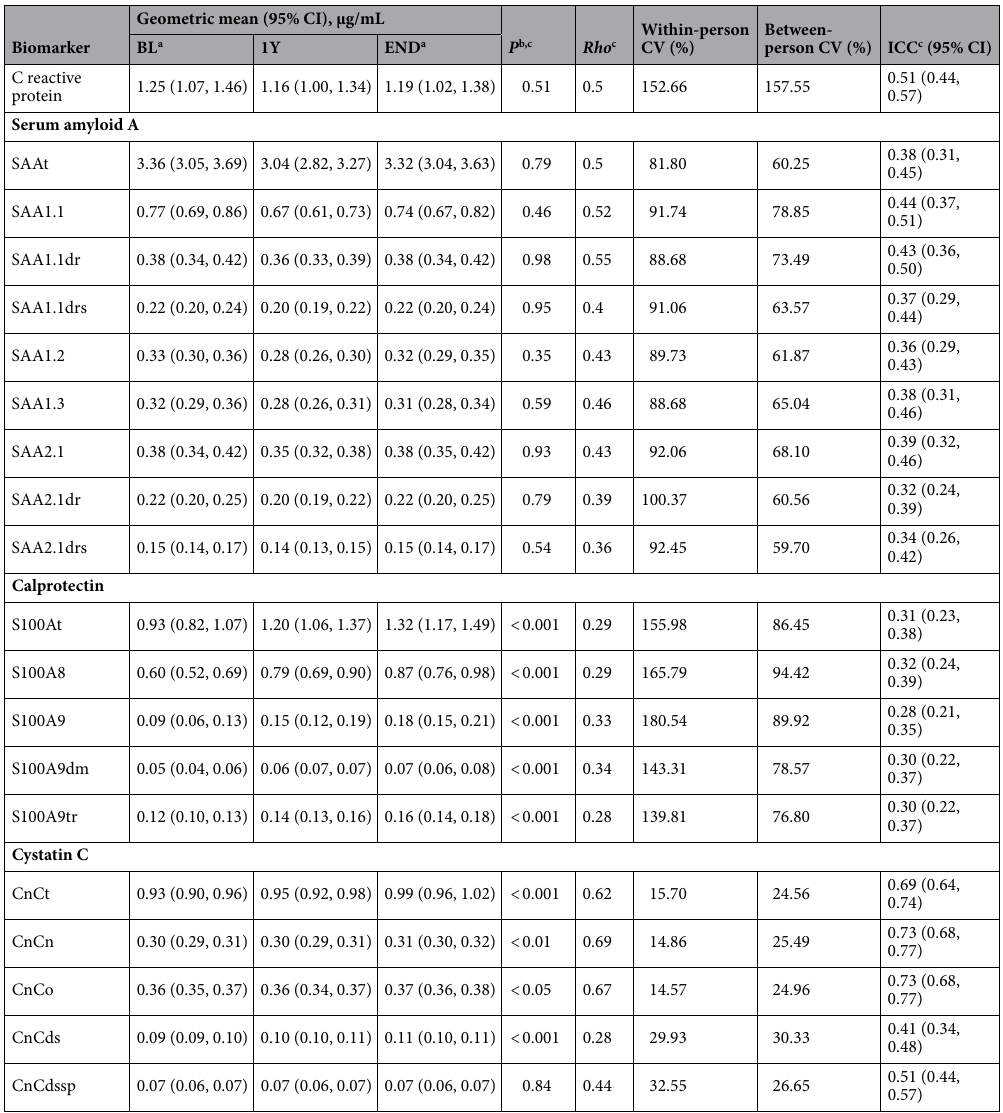
Table 2. Concentrations and within-person reproducibility of biomarkers in EDTA plasma samples from WENBIT. Samples collected at 3 time points over 3y apart from 295 SAP patients enrolled in the Western Norway B Vitamin Intervention Trial. Within- and between-person CVs were determined by taking the square root of the within- and between-person variance components from random-effects mixed model on the ln-transformed values. a BL Baseline, END End of follow-up. b Significant differences in biomarker geometric mean were evaluated by t-test. c Values were obtained from the data at BL and